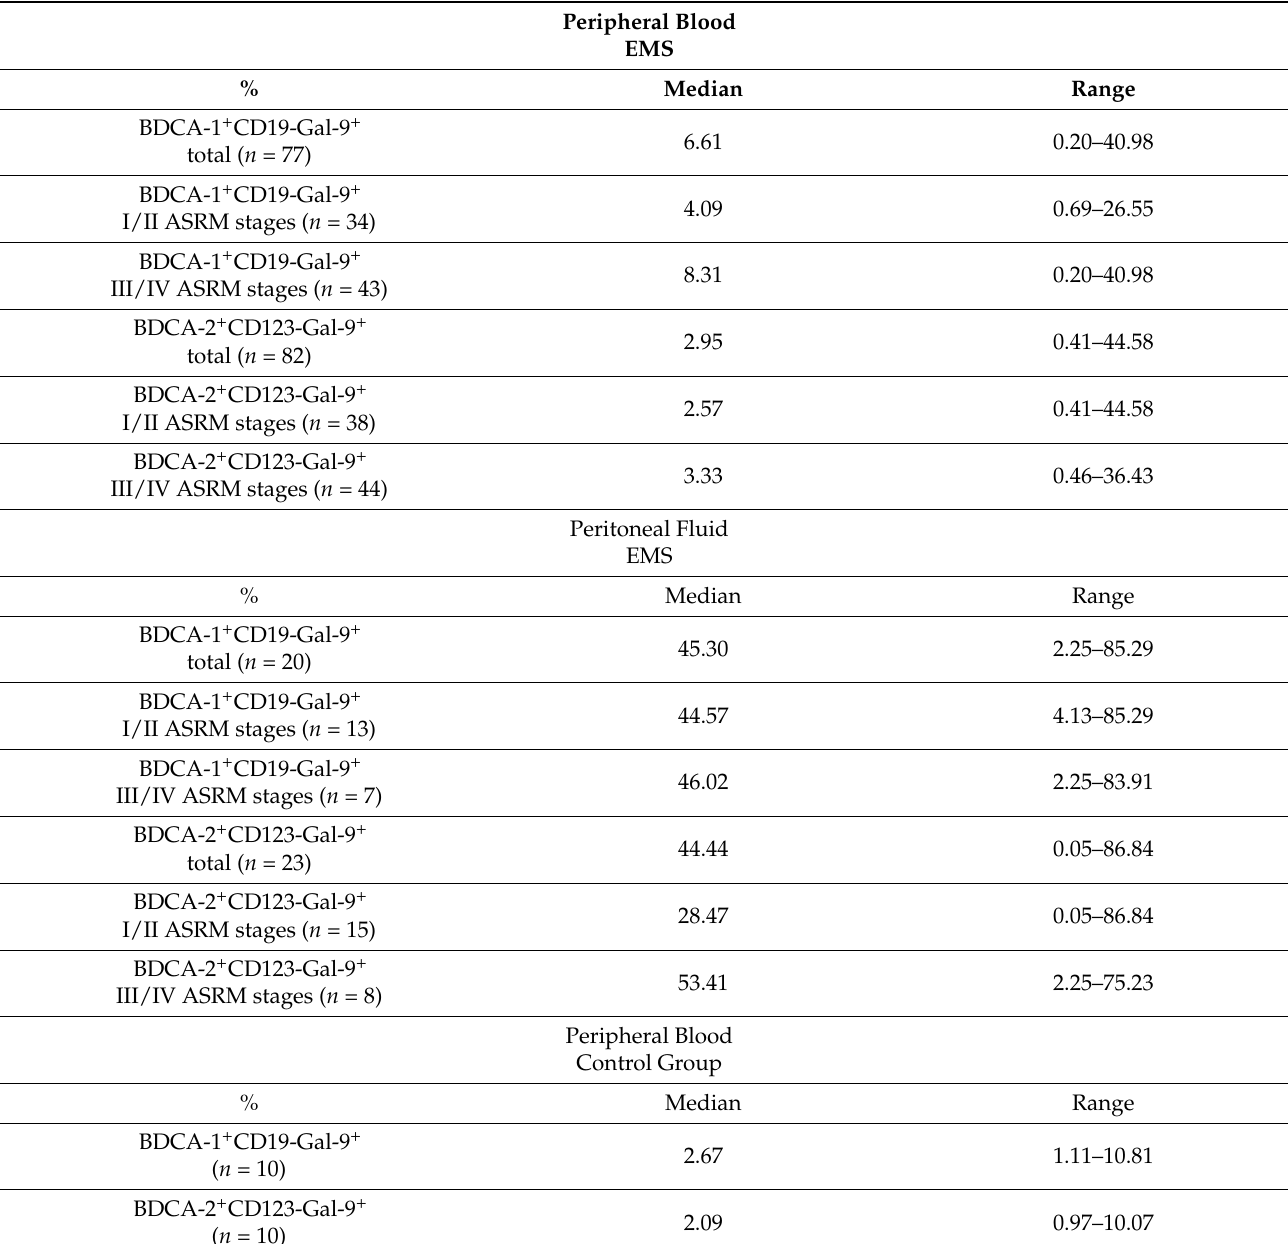
Table 1. Percentage of Gal-9-positive dendritic cells in patients with endometriosis and the control